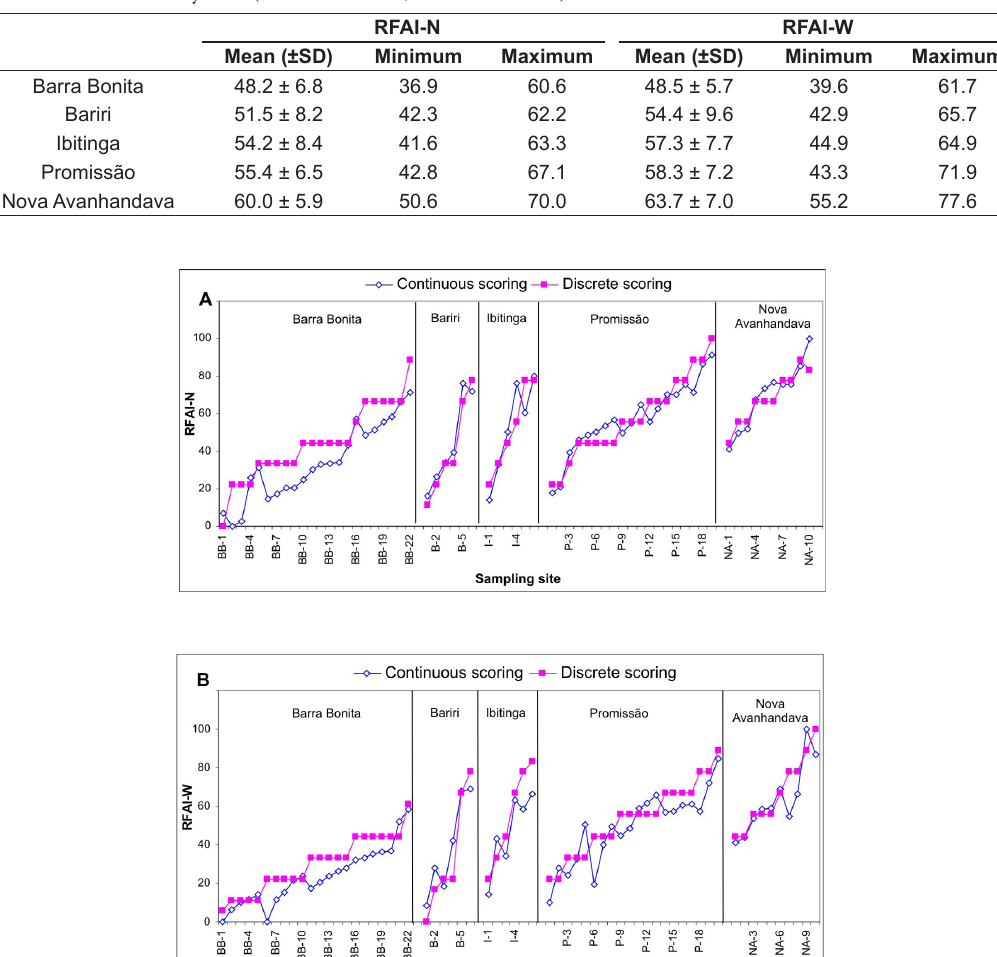
Table 2. Mean values, standard deviation, minimum and maximum values of the final RFAI-N and RFAI-W for the Tietê cascade reservoir system (see Petesse et al., 2014 for details).